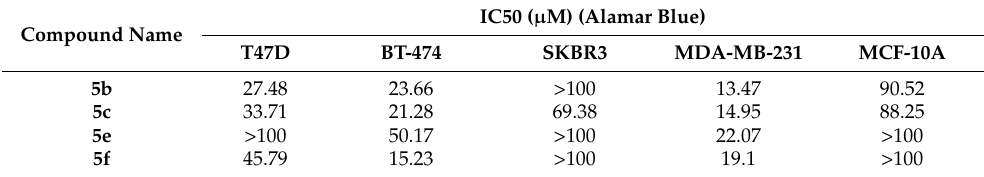
Table 3. Cytotoxicity data of pyranopyrazoles against TNBC and MCF-10A cells.